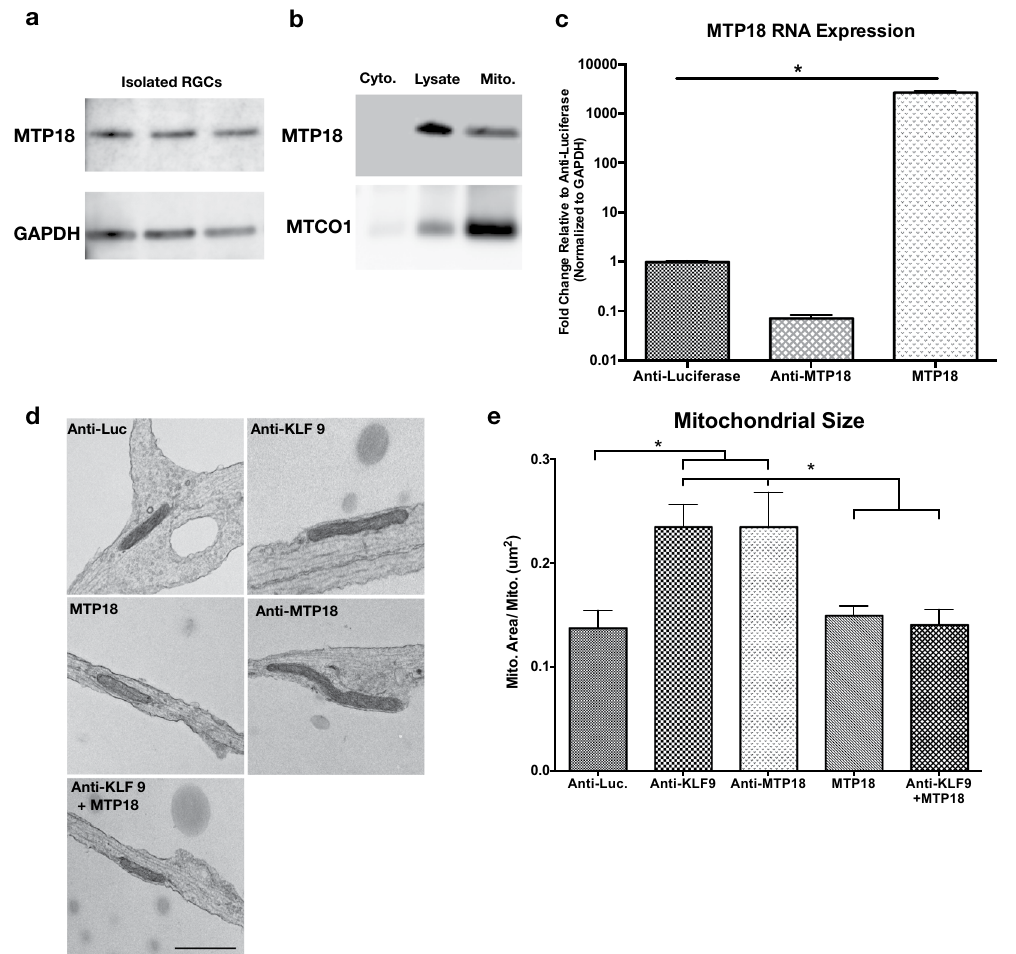
Figure 4. MTP18 is a mitochondria associated protein that regulates mitochondrial size in RGCs. ( a ) Western blot of RGC lysates from 3 replicate RGC purifications probed for MTP18 and GAPDH as a loading control. RGCs were purified from P4 rat retinas. Blots were cut, individually probed with antibodies and then imaged. ( b ) Western blot of a mitochondrial enriched fraction (mito.) cytosolic fraction (cytosolic), and crude total cell lysate fraction (lysate) from adult rat retinas. Samples probed using an MTP18 antibody and Cytochrome c oxidase subunit 1 antibody (MTCO1), to validate mitochondrial enrichment. Images were captured from the same blots, sequentially probed with antibodies. ( c ) MTP18 mRNA expression after AAV2 mediated expression of Anti-luciferase (Anti-Luc), Anti-MTP18, and MTP18 expression vectors in P4 RGCs. Data captured by QRT-PCR, normalized to GAPDH and expressed as mean expression relative to Anti-luciferase (N = 3 replicate treatments, significance ascribed by one-way ANOVA and Tukey multiple comparison, * p ≤ 0.05). ( d ) TEM images of mitochondria in P4 RGCs neurites treated with indicated AAV2 viruses or combinations of virus (scale bar 1 µ m). ( e ) Mean area of mitochondria identified in P4 RGC neuritis are graphed for each representative AAV2 treatment group, N ≥ 15 de-identified neurite images selected from 3 replicate viral treatments per group (significance determined by one-way ANOVA and Tukey multiple comparison, * p ≤ 0.05). All error bars represent + SEM. Full length blots are available in Supplemental Fig.